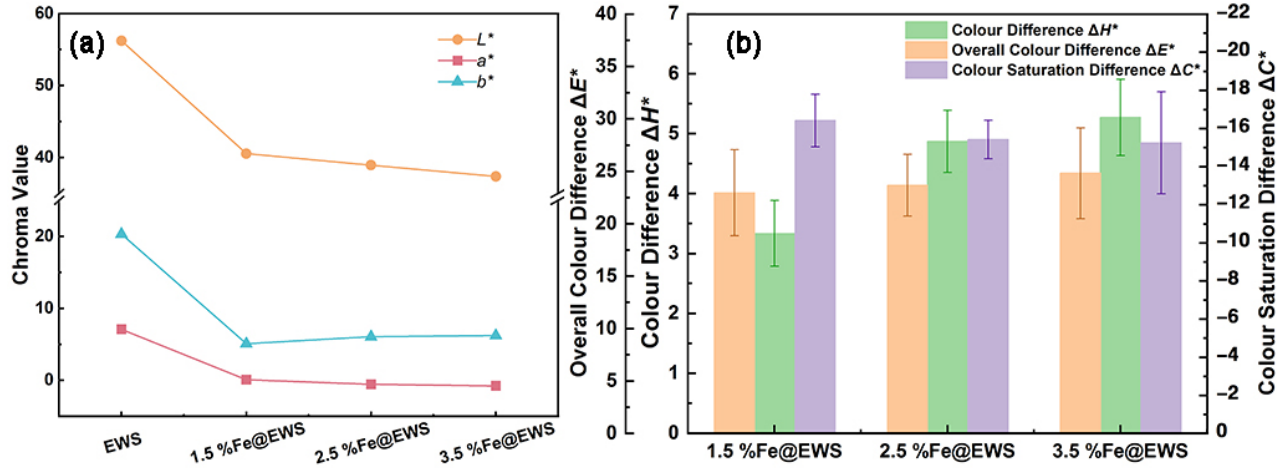
Figure 4. Changes in chromaticity coordinate a *, b *, L * of EWS, 1.5%Fe@EWS, 2.5%Fe@EWS, and 3.5%Fe@EWS ( a ); changes in color saturation difference Δ C* , color difference Δ H* , and overall color difference Δ E * of 1.5%Fe@EWS, 2.5%Fe@EWS, and 3.5%Fe@EWS ( b ).